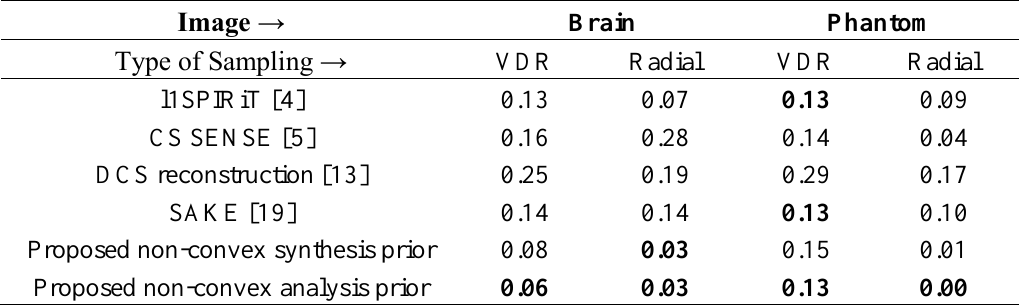
Table 1. Comparison of reconstruction accuracies for calibration-free